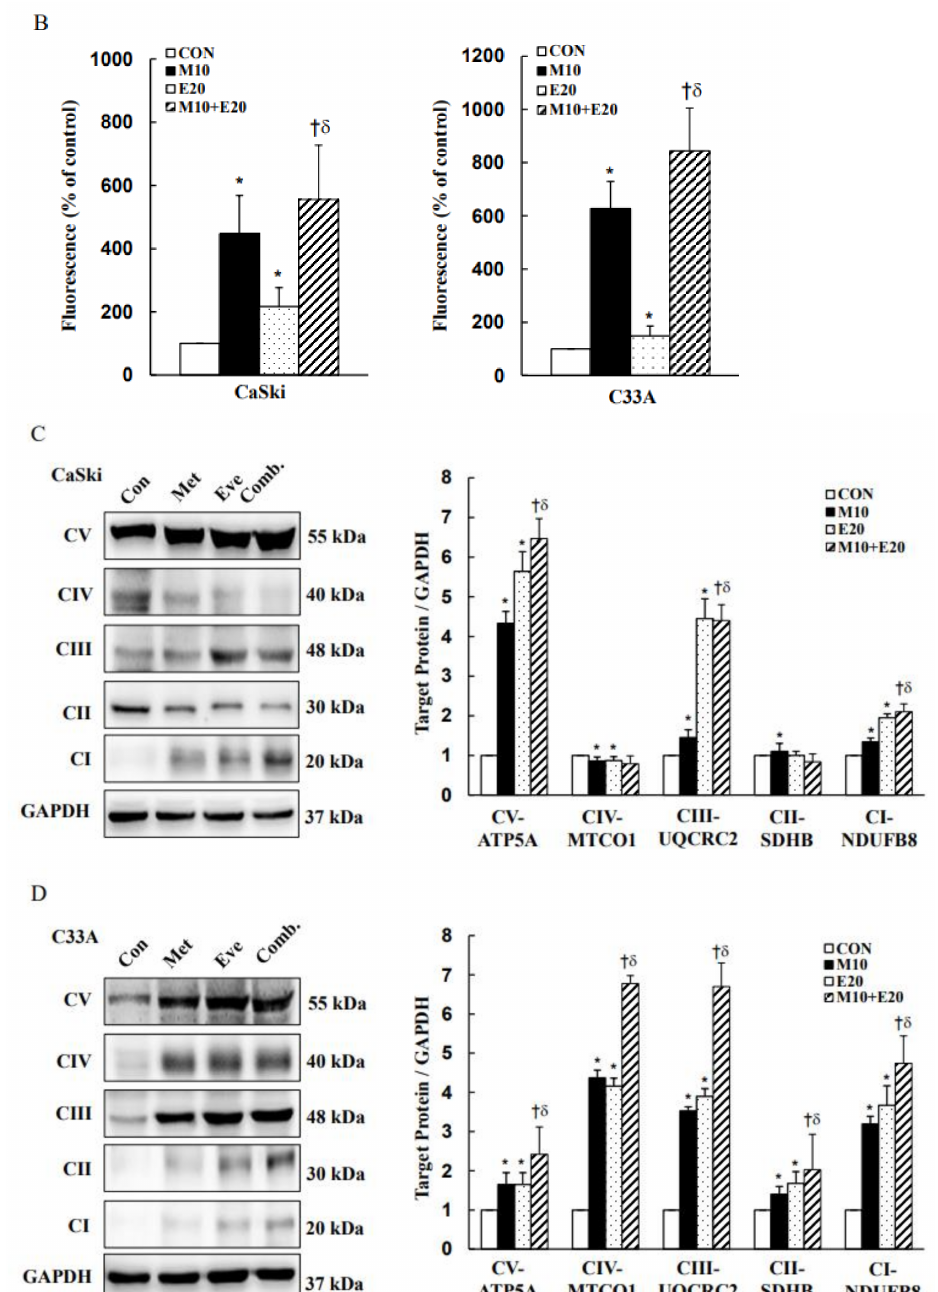
Figure 4. Metformin and everolimus enhanced mitoROS-mediated OXPHOS expression in cervical cancer cells. CaSki and C33A cells were treated with metformin (10 mM) with or without everolimus (20 µ M) for 48 h. ( A ) Mitochondrial ROS levels measured using MitoSOX Red reagent via flow cytometry. ( B ) Quantitative results of mitochondrial ROS levels presented in the bottom plot. ( C , D ) Protein expression levels of OXPHOS (complex I–V) measured using Western blotting. Quantitative results presented in the bottom plot. Values represent the mean ± SD from three replicates. *, † and δ p < 0.05 compared with CON, Met 10- or Eve 20-treated groups. CON, 0.1% DMSO; M10, 10 mM metformin; E20, 20 µ M